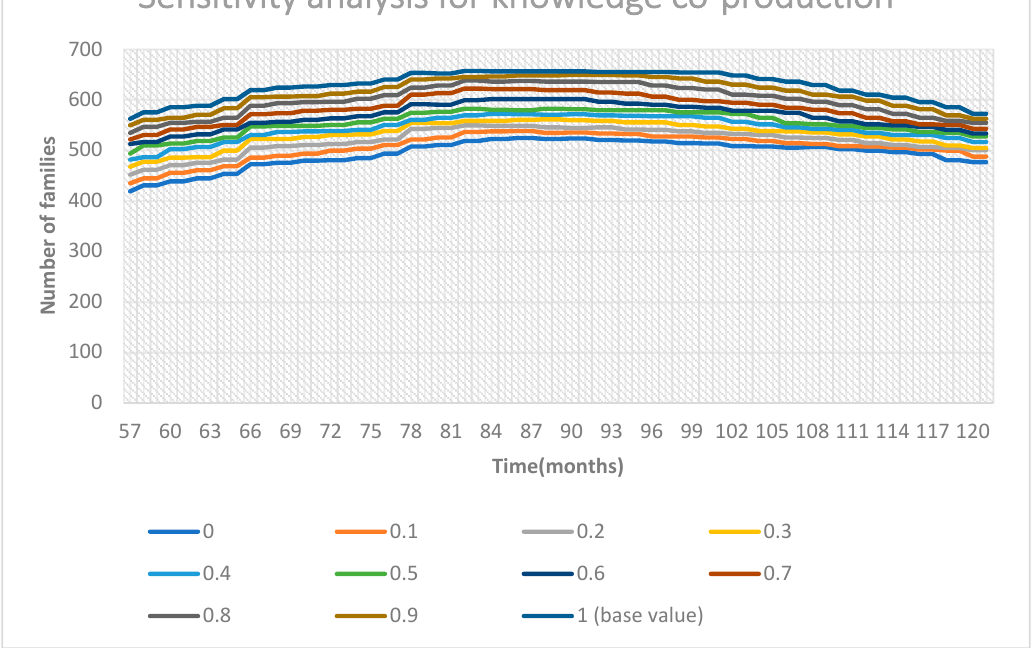
Figure 8. The effect of different weights of knowledge co-production on transformation outcomes.